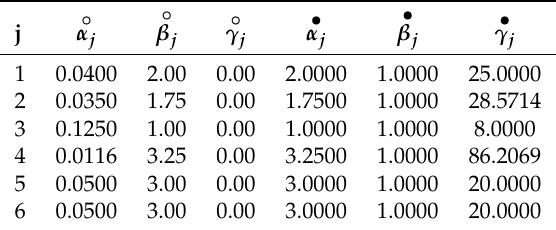
Table 2. The parameter values use for constraint set.